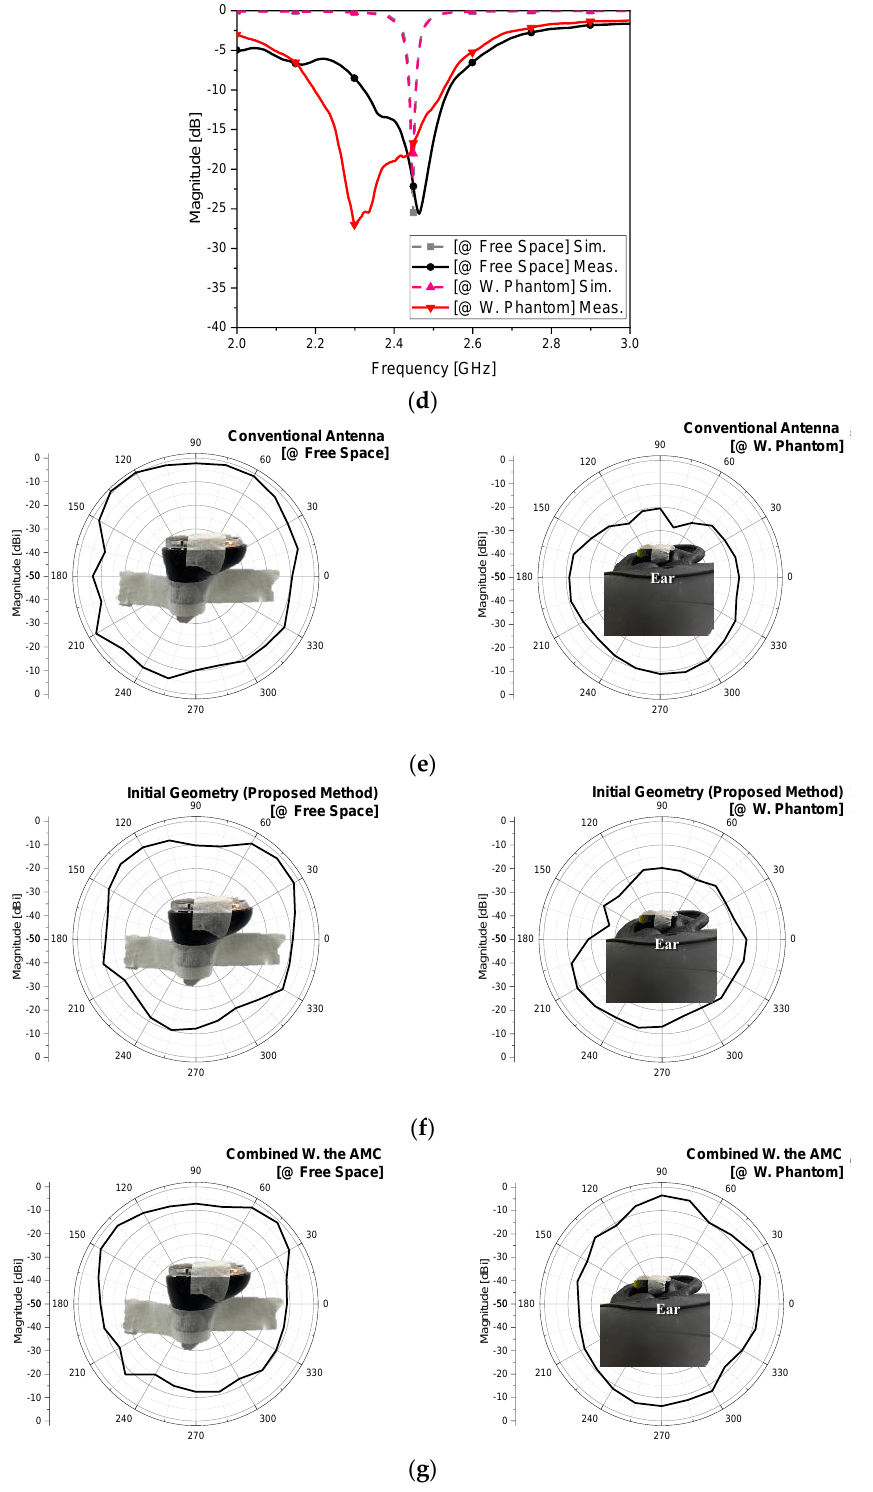
Figure 5. Fabricated antennas and measured S 11 and far-field patterns for the conventional antenna (CA) and OFAA: ( a ) photographs and S 11 of ( b ) CA; ( c ) initial geometry (short radiator without the AMC); ( d ) OFAA; ( e ) beam pattern of the CA ( left ) in free space and ( right ) in the ear; ( f ) beam pattern of the initial geometry ( left ) in free space and ( right ) in the ear; ( g ) beampattern of the OFAA ( left ) in free space and ( right ) in the ear.